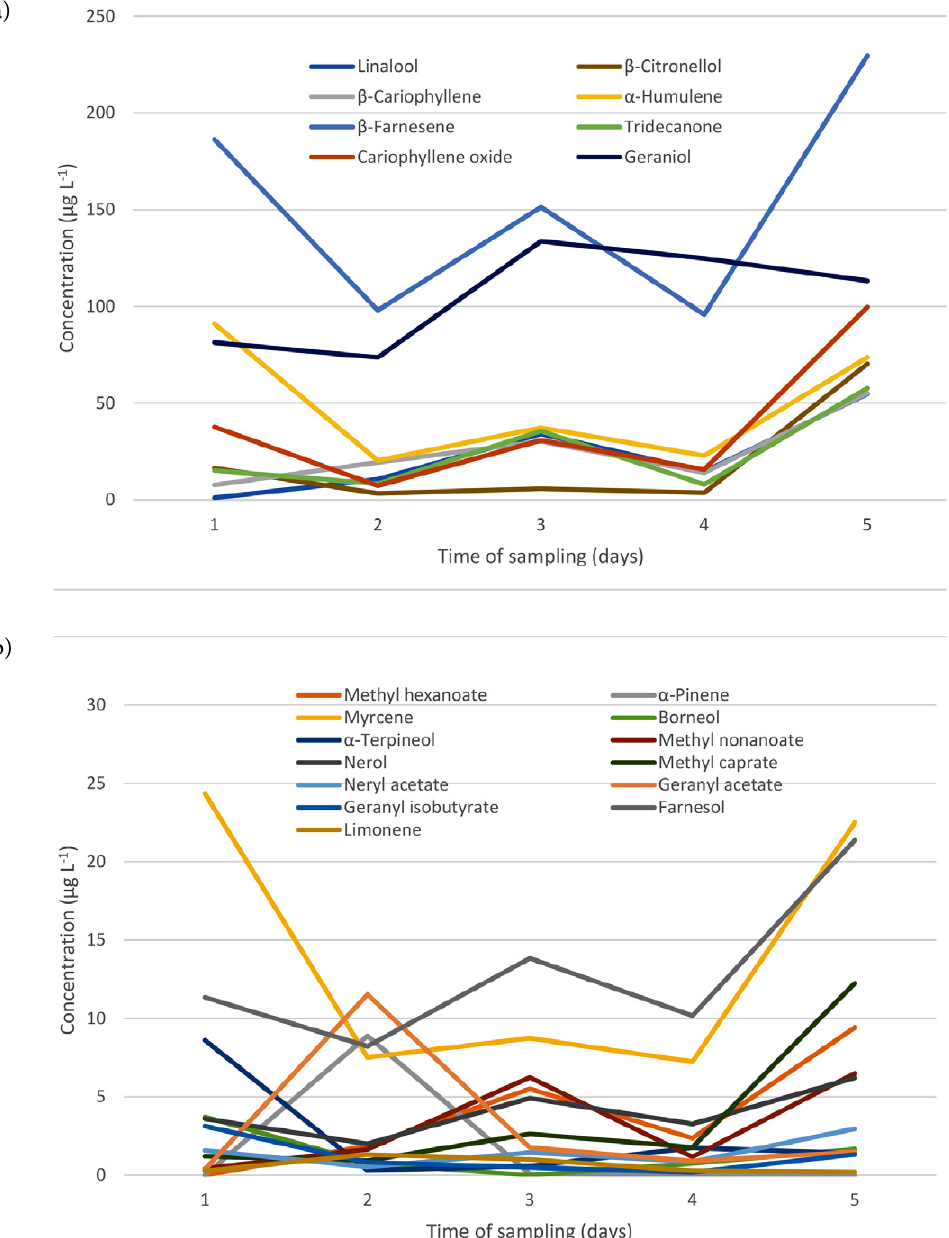
Figure 4a and 4b. Transition of hop essential oil components during